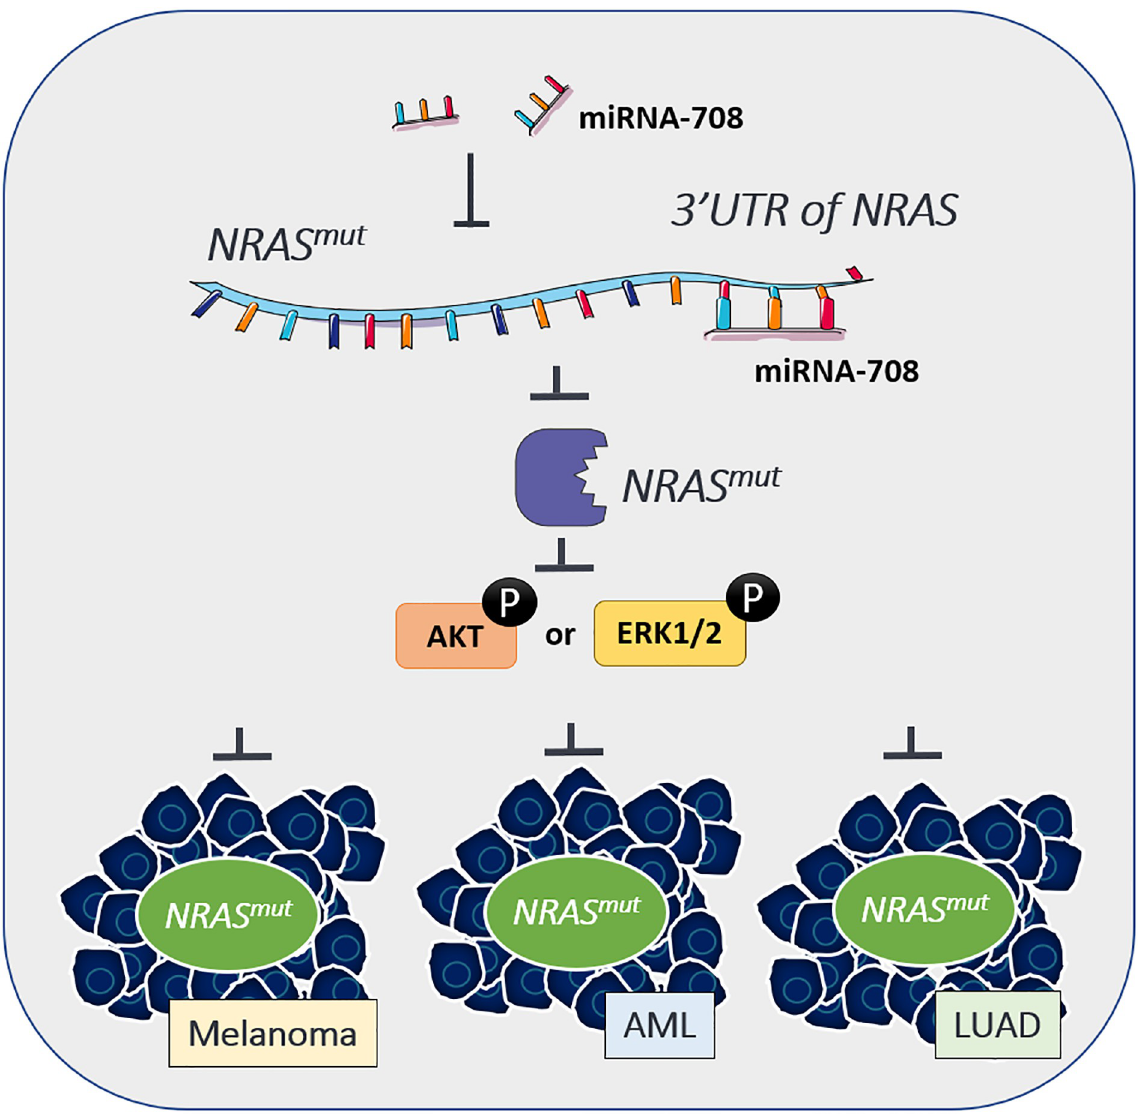
Fig 6. Working model of miR-708 suppresses cancer progression in NRAS mutated cancers. Expression of miR-708 depletes NRAS and impairs downstream PI3K/AKT/mTOR or RAF/MEK/ERK activation, resulting in the suppression of cell proliferation, anchorage-independent growth, and enhanced reactive oxygen species-induced apoptosis in NRAS -mutation driven cancer cells. MicroRNA-708 possesses the potential to be developed as the targeted therapy for NRAS mutant melanoma, AML, LUAD et cetera.